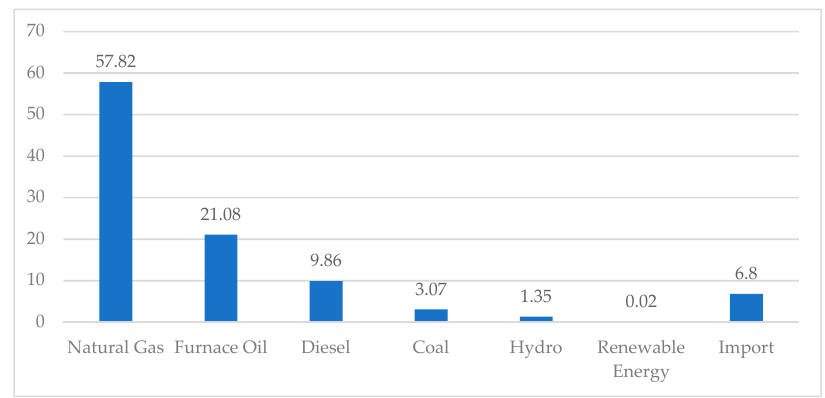
Figure 1. Power generation by fuel type (percentage) in Bangladesh [19].